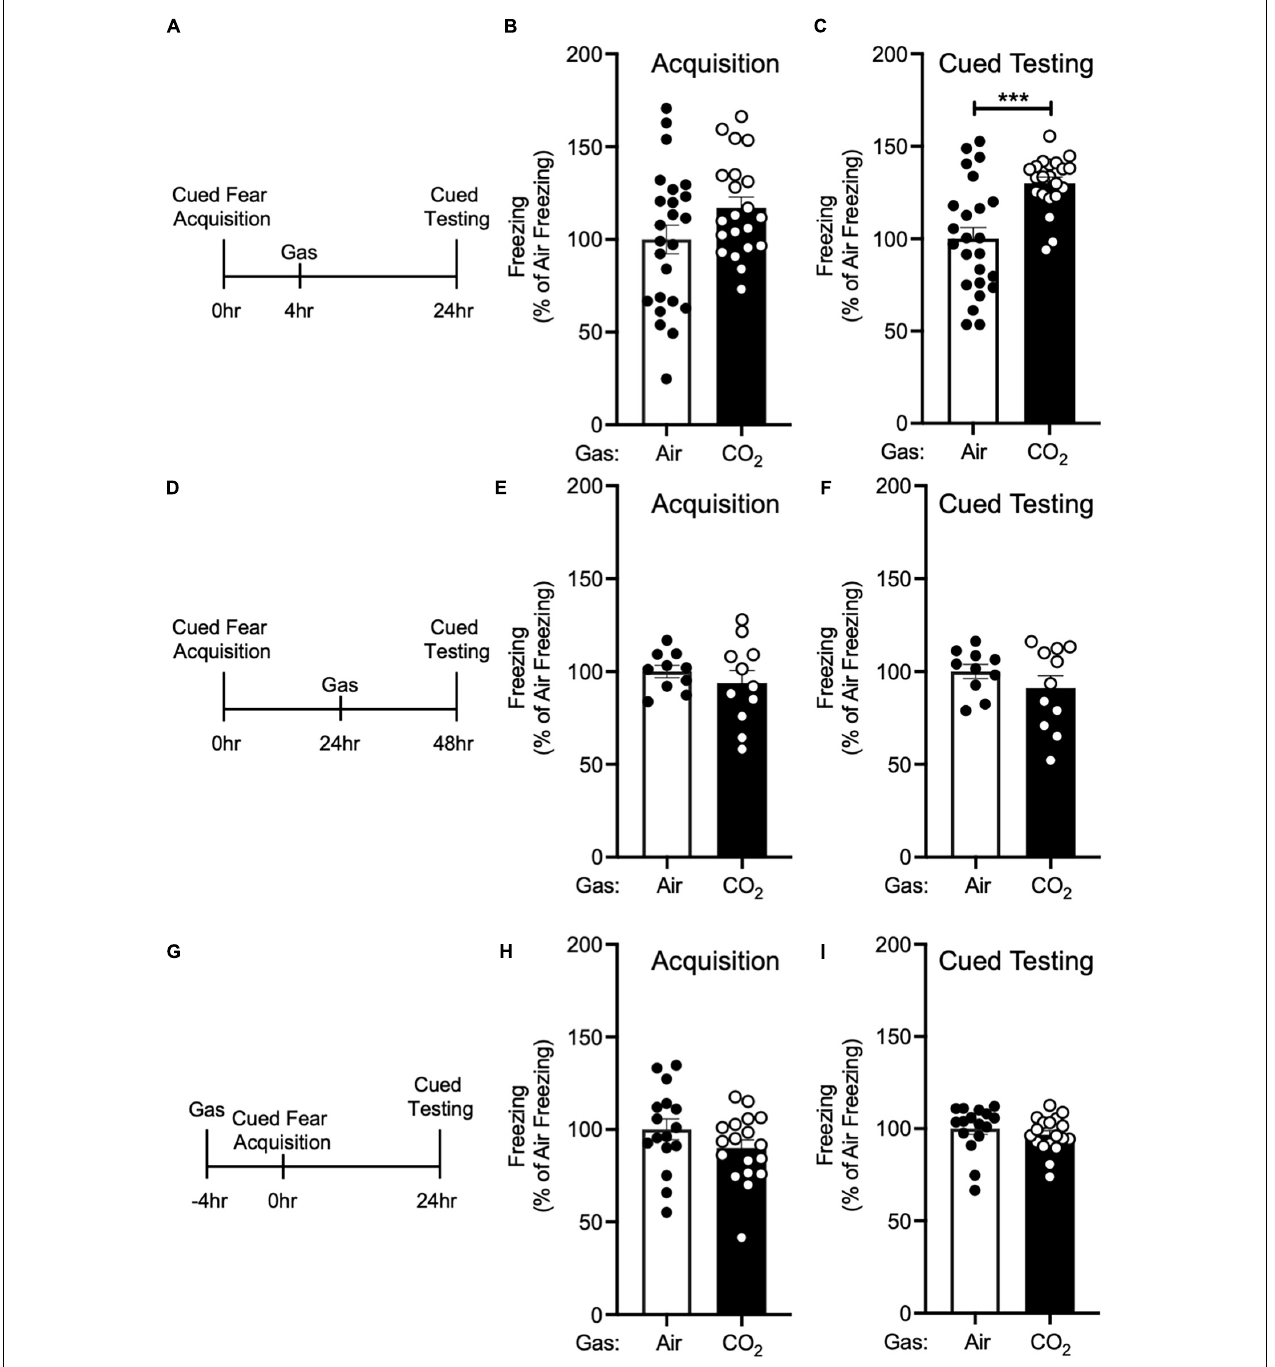
FIGURE 2 | The enhancing effect of CO 2 inhalation on cued fear memory is time-dependent. (A) Experimental timeline. 4 h after cued fear acquisition, mice were exposed to air or 10% CO 2 for 30 min. 24 h after acquisition, cued fear memory was assessed. (B) Freezing during acquisition prior to gas exposure did not differ significantly between air and 10% CO 2 -treated groups [ t (43) = 1.748, p = 0.0876, n = 24, 21]. (C) Exposure to 10% CO 2 4 h after acquisition increased freezing during the cued fear test [ t (34.49) = 4.359, *** p = 0.0001]. (D) Experimental timeline. 24 h after cued fear acquisition, mice were exposed to air or 10% CO 2 for 30 min. 24 h after gas exposure, cued fear memory was assessed. (E,F) In mice exposed to gas 24 h after acquisition, freezing during acquisition prior to gas exposure did not differ between air and 10% CO 2 -treated groups (E) [ t (14.49) = 0.8350, p = 0.4173, n = 10, 11] nor did freezing during the cued fear test (F) [ t (19) = 1.129, p = 0.2731]. (G) Experimental timeline. 4 h before cued fear acquisition, mice were exposed to air or 10% CO 2 for 30 min. 24 h after acquisition, cued fear memory was assessed. (H,I) When acquisition occurred 4 h after gas exposure, CO 2 treatment had no effect on freezing during acquisition (H) [ t (32) = 1.435, p = 0.1610, n = 16, 18] or freezing during the cued fear test was observed (I) [ t (32) = 0.8642, p = 0.3939].